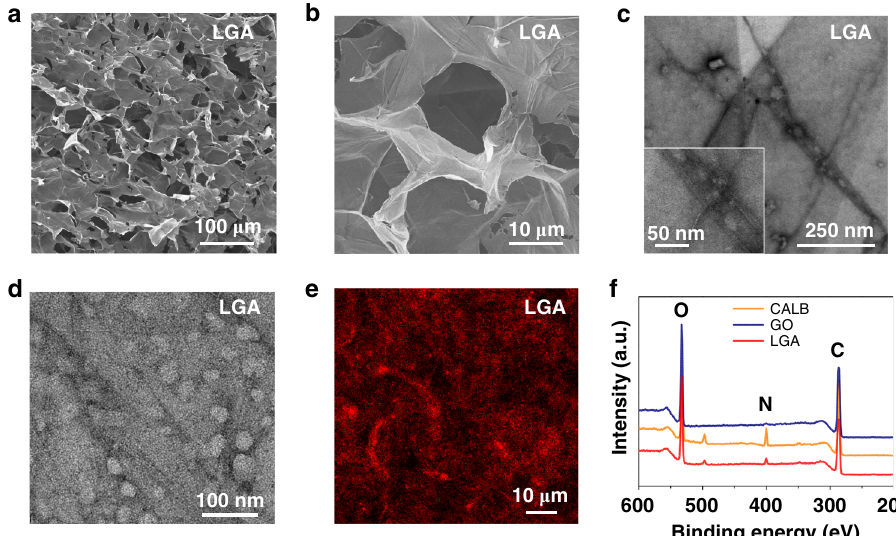
Fig. 3 Structural characterization of LGA. a , b SEM images; c STEM image; d TEM images; e Laser confocal microscopy images with the CALB labeled with Rhb (red); f XPS data of CALB, GO, and LGA. Source data are provided as a Source Data fi